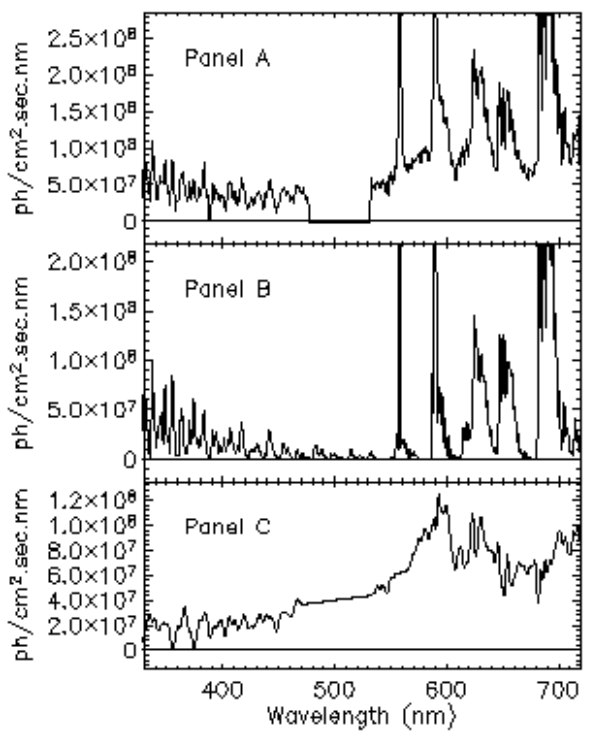
Fig. 5. (A) OSIRIS averaged tangent limb spectrum for June and July of 2003. The gap from 480nm to 530nm is the location of the OSIRIS spectral order sorter. (B) Simulated night airglow spec- trum scaled to match (A) observed spectral features. (C) Residual spectrum ( A minus B ). The observed difference spectrum is spec- trally convolved with a 2.5nm half width triangular function to im- prove figure clarity. The data gap from 480nm to 530nm in (C) is filled assuming linear interpolation, and similarly for the strong OI 558nm region.